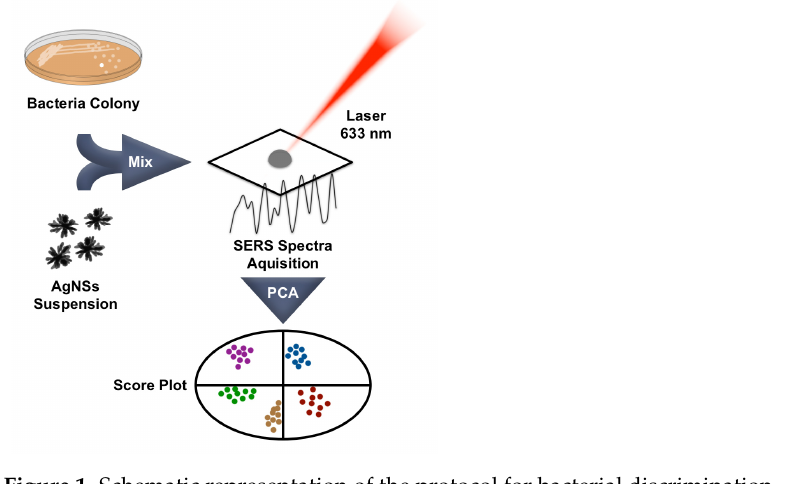
Figure 1. Schematic representation of the protocol for bacterial discrimination.